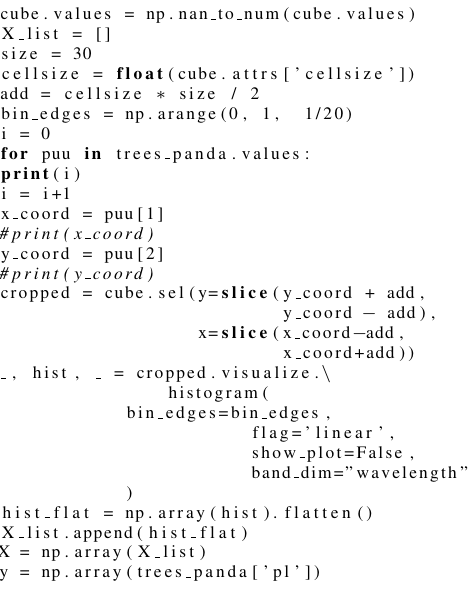
Figure 19. Calculating histograms and preparing data for machine learning algorithm.